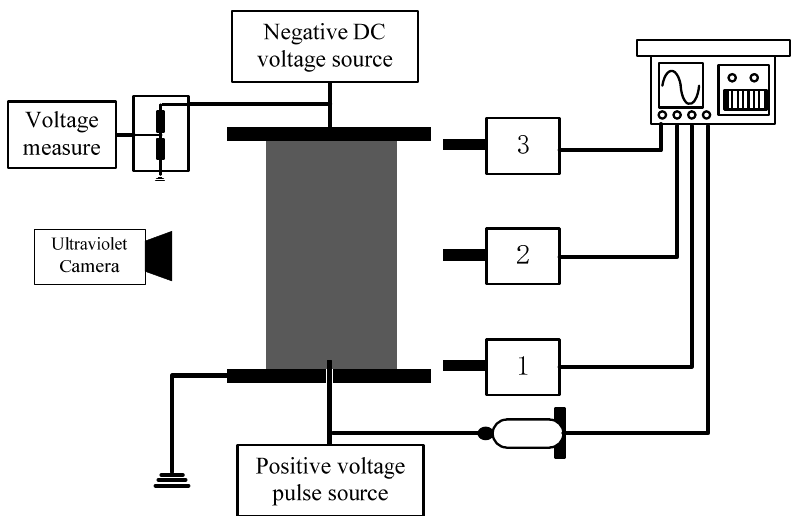
Figure 1. Schematic of the experiment arrangement and measurement equipment.